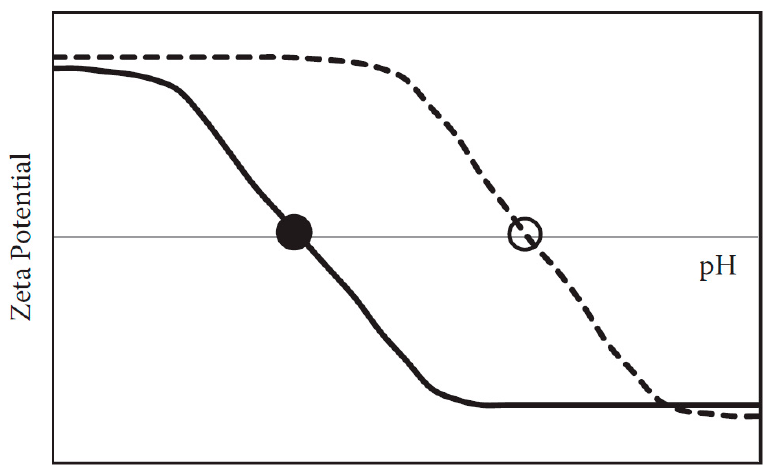
Figure 10. Plot of pH and zeta potential of polyelectrolyte (—) and substrate (---); ⚫ , iso-electric point of polyelectrolyte; and ○ , iso-electric point of substrate (adapted with permission from [196]).